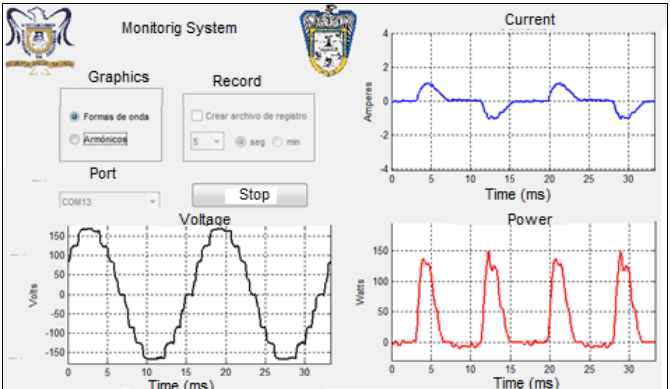
Figure 15: Waveforms obtained with the prototype in the multilevel inverter and inductive-resistive load.